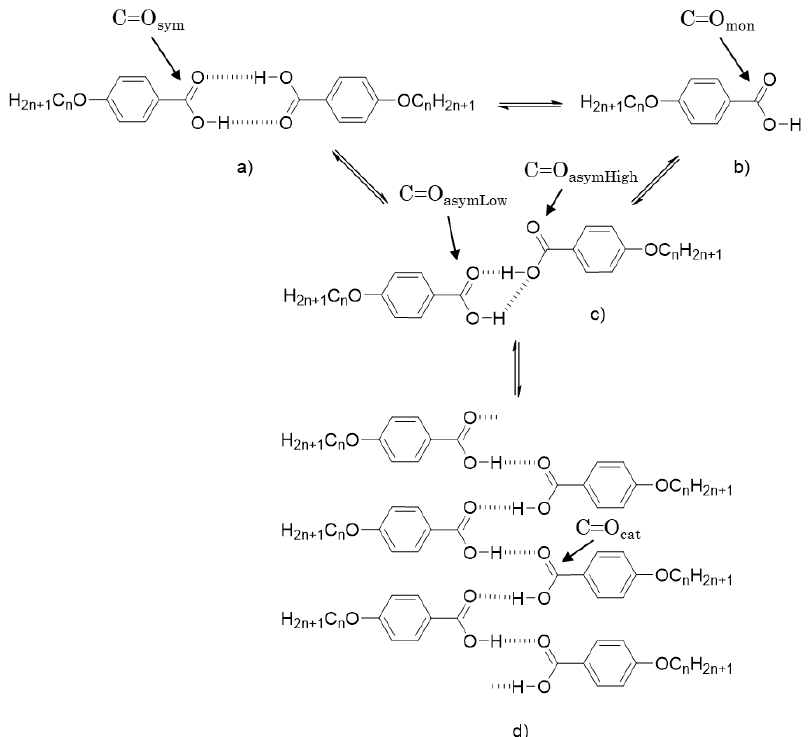
Figure 9. Equilibria between the species in the alkoxybenzoic acids and the corresponding types of carbonyl groups involved, C=O: ( a ) Symmetric dimers, C=O sym ; ( b ) Monomeric species, C=O mon (free acids); ( c ) Asymmetric dimers, C=O asym ; acting as hydrogen bond donors, C=O asymLow , or attached